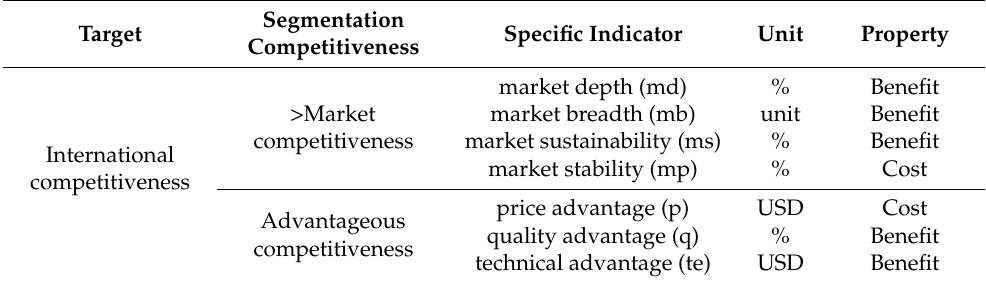
Table 1. The index system of the international competitiveness of forest products in an uncertain trading